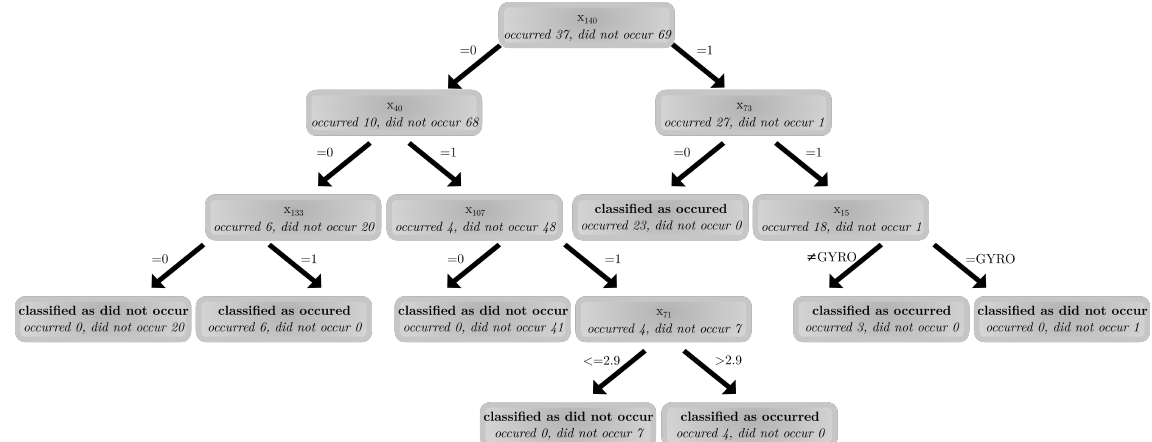
Figure 4. An example tree developed for the event e 22